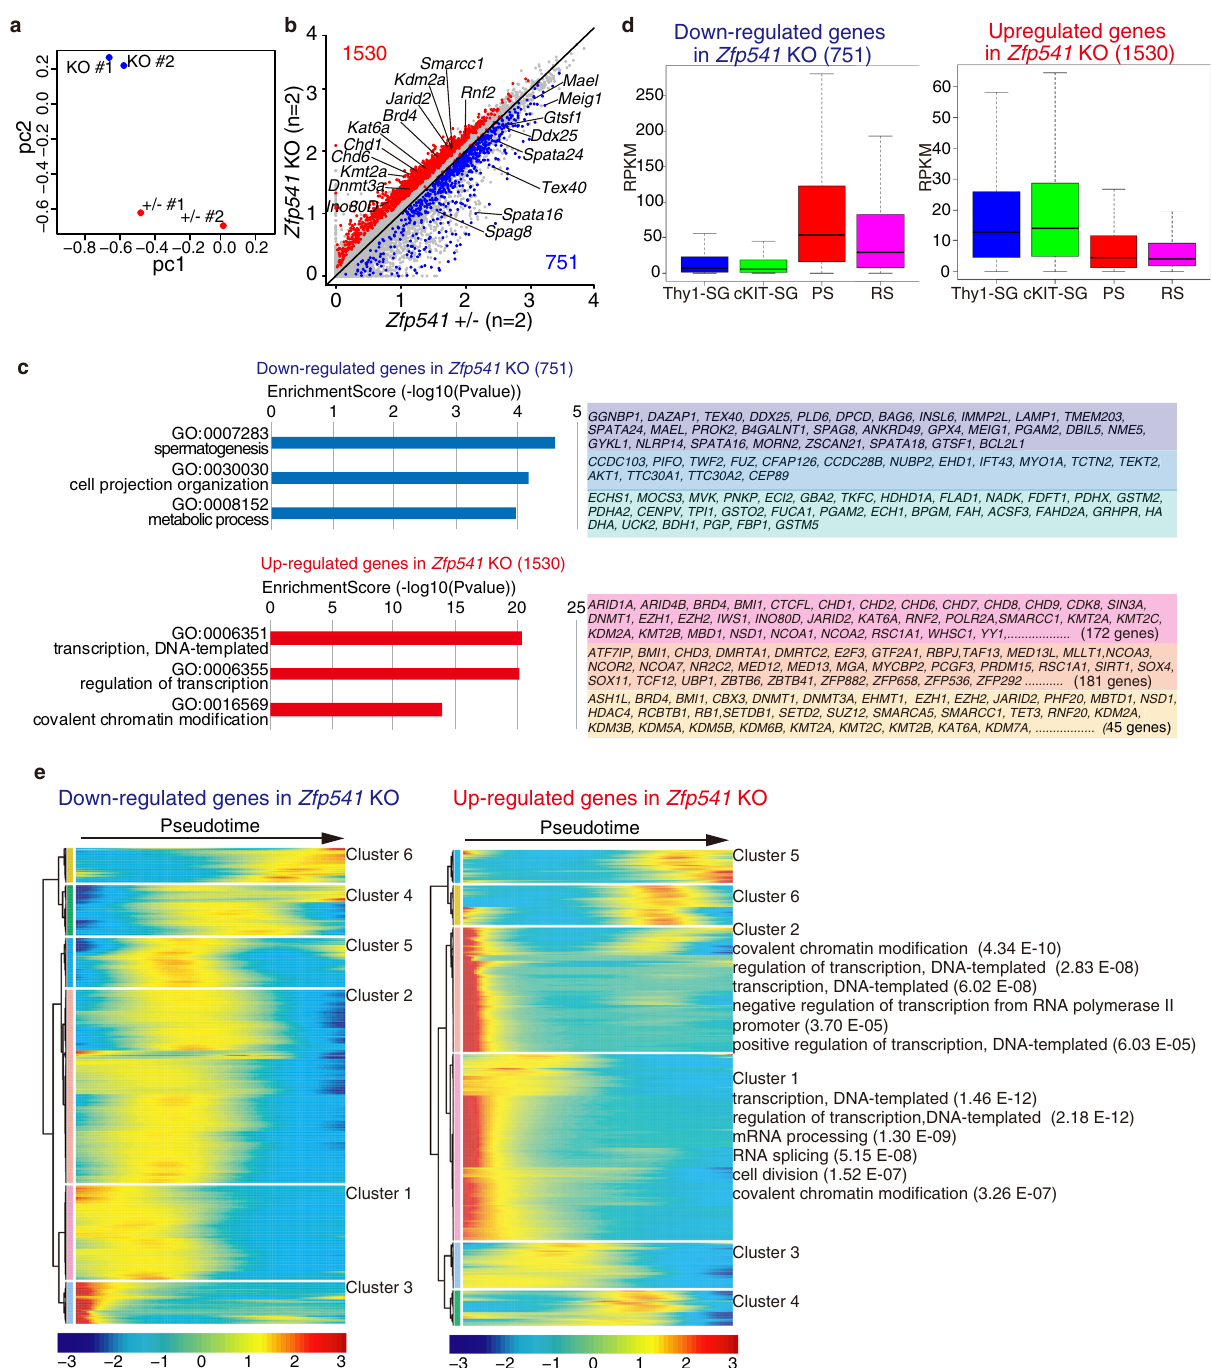
fi rst wave of spermatocyte should progress with the same cellular composition in the control Zfp541 + / − and Zfp541 KO